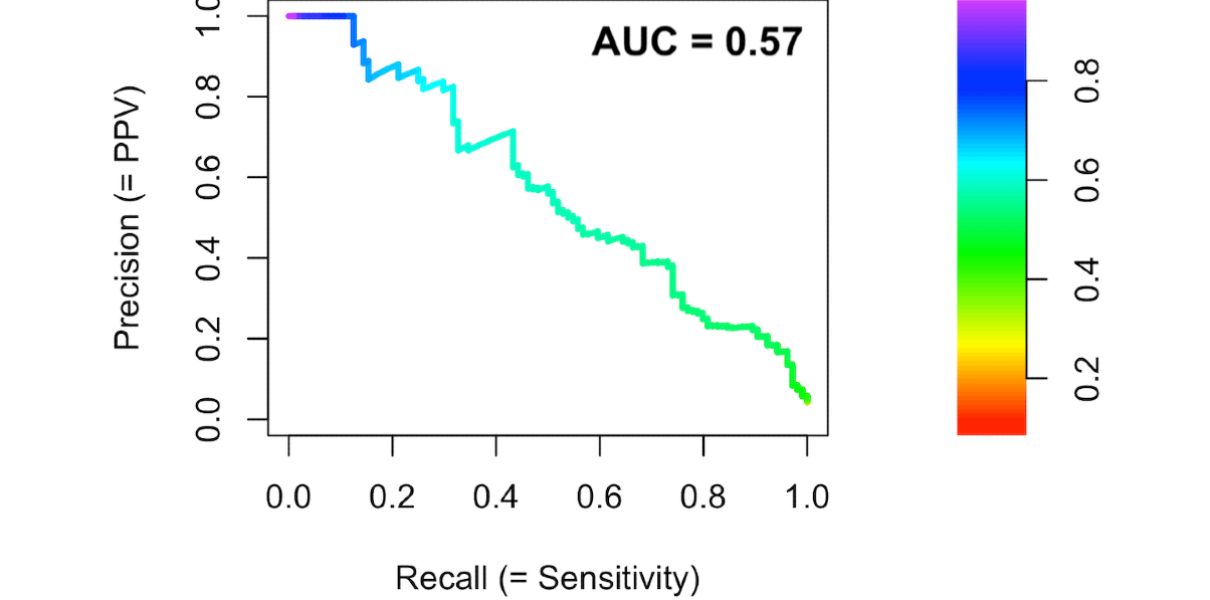
Figure 4. Precision recall curve for neural network prediction of exceeding the American Academy of Pediatrics–recommended phototherapy initiation threshold on the subsequent bilirubin measurement in newborn infants ≥ 35 weeks of gestation. The area under the precision recall curve was 0.573; for this data set, a no-skill classifier would have an area under the precision recall curve of 0.043. The color represents the decision threshold value corresponding to the precision and recall on the curve. AUPRC: area under the precision recall curve; PPV: positive predictive